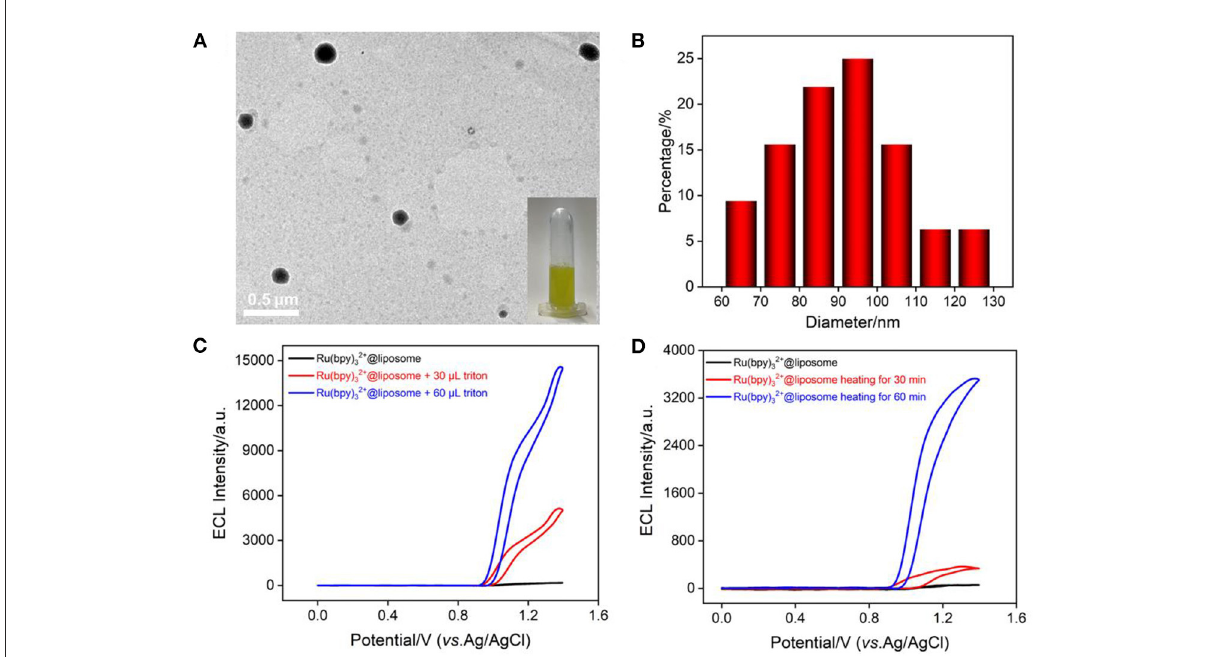
FIGURE3 (A) TEM image of Ru(bpy) 32 + @liposome. The inset is a digital photo of Ru(bpy) 32 + @liposome solution. (B) Size distribution of Ru(bpy) 32 + @liposome. (C,D) ECL intensity-potential curves of Ru(bpy) 32 + @liposome when adding different concentrations of triton or heating (50 ◦ C) for different times. The voltage of the photomultiplier tube (PMT) is